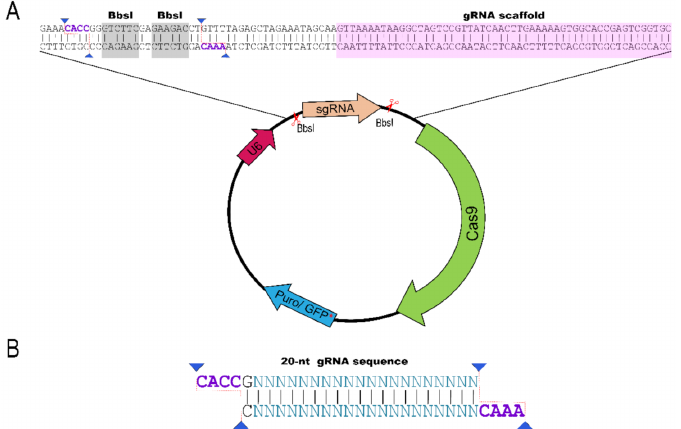
Figure 5. Plasmidial system to express CRISPR/Cas9 system. ( A ) CRISPR/Cas9 plasmid contains a site for BbsI digestion that creates the cloning site for the 20-nt sequence sgRNA; ( B ) The sgRNA sequence is ligated into BbsI-digested plasmids PX458 (GFP) or PX459 (puromycin resistance) as annealed DNA oligonucleotides with cohesive ends as shown in the figure CACC in the 5 (cid:48) and CAAA in the 3 (cid:48)